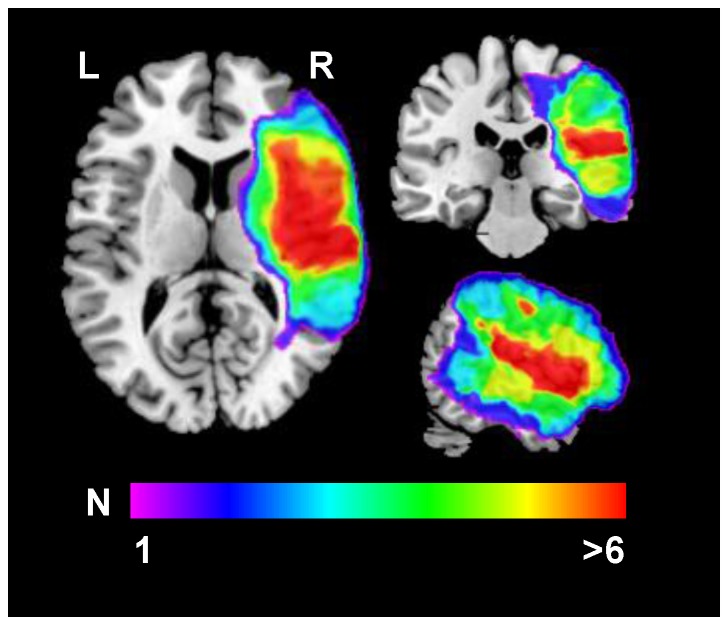
Lesion overlay plot (N = 9).Lesion overlap was highest in the right posterior superior temporal gyrus and insula as indicated by reddish colours, N: # patients with lesion, L: left, R: right, position of slices (MNI coordinates x/y/z): 54/-26/12.